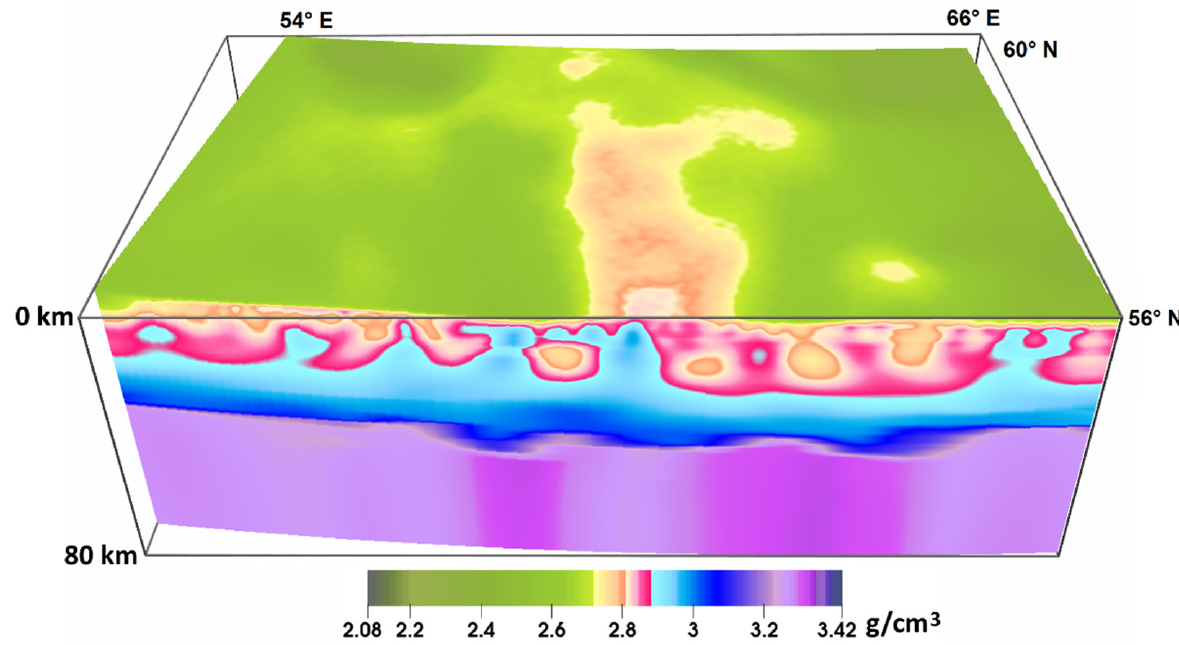
Figure 15. Fitted 3D density model for noised field.